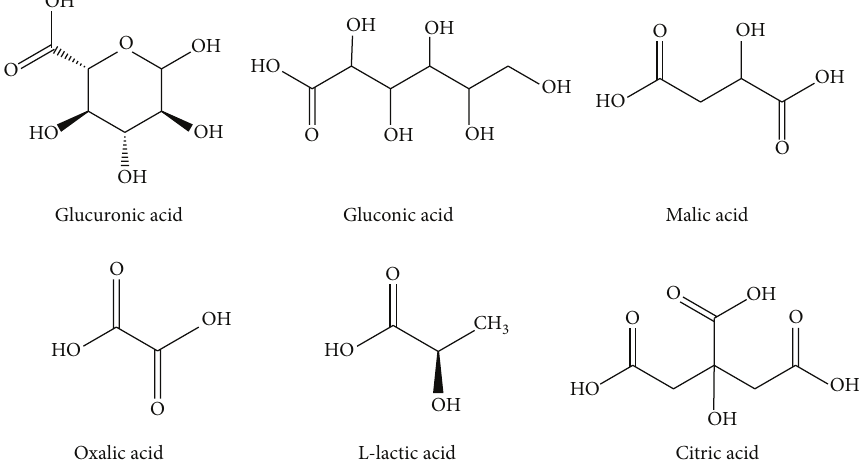
Figure 2: The most abundant organic acids found in Kombucha tea as a result of the fermentation process.